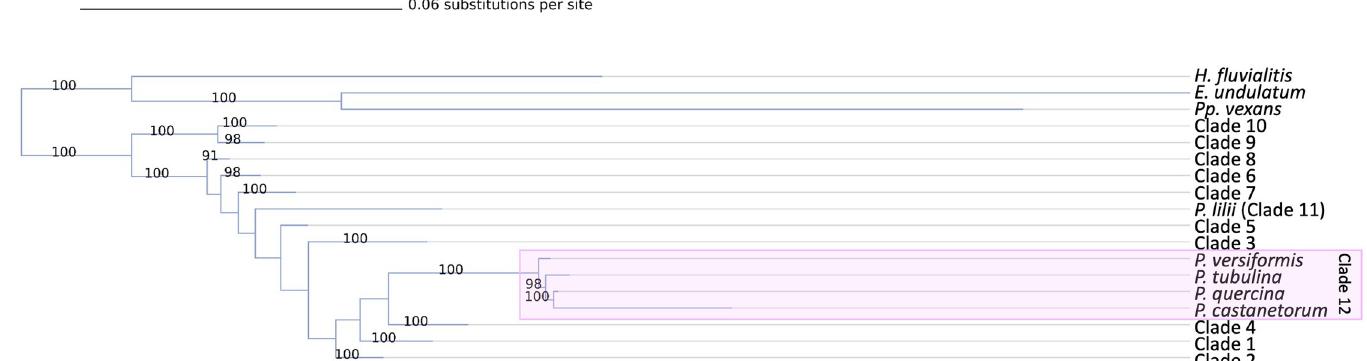
Fig 3. Phylogeny of major Phytophthora clades. Collapsed phylogenetic tree of the genus Phytophthora showing the relationships between the clades, outgroups, and species that do not fit into the conventional clade system. Clade 12 is highlighted in pink. Phylogeny is inferred using maximum likelihood and 1,000 bootstrap replicates for an alignment of 8 concatenated nuclear loci. Bootstrap values (in percent) are shown above each branch. The branches in the tree are drawn to scale and the scale bar represents 0.06 substitutions per site.